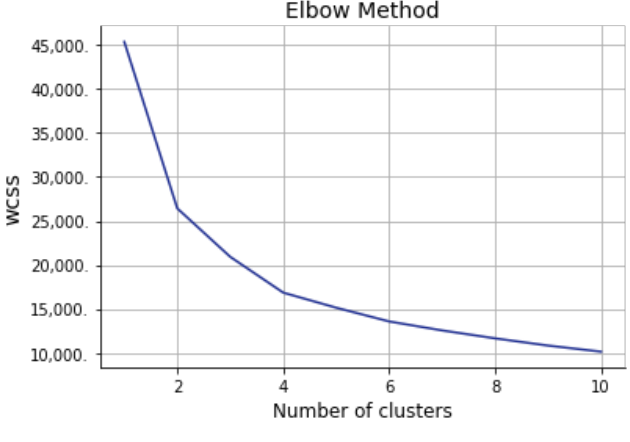
Figure 12. Elbow method for finding the optimal number of clusters.